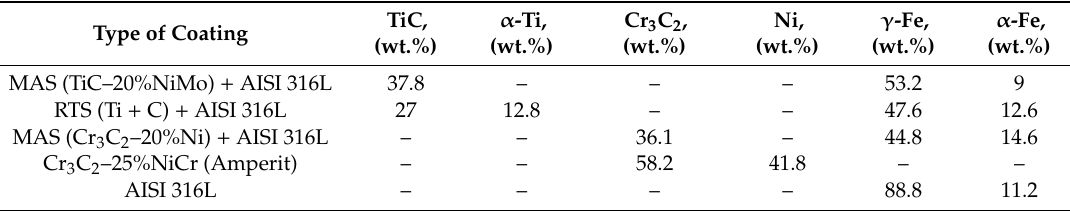
Figure 6. XRD patterns of the HVOF sprayed coatings. ( a ) Ti-based MAS coating; ( b ) Ti-based RTS coating; ( c ) Cr-based MAS coating; ( d ) Reference coating (Amperit). Table 6. Phase composition of the HVOF sprayed coatings.